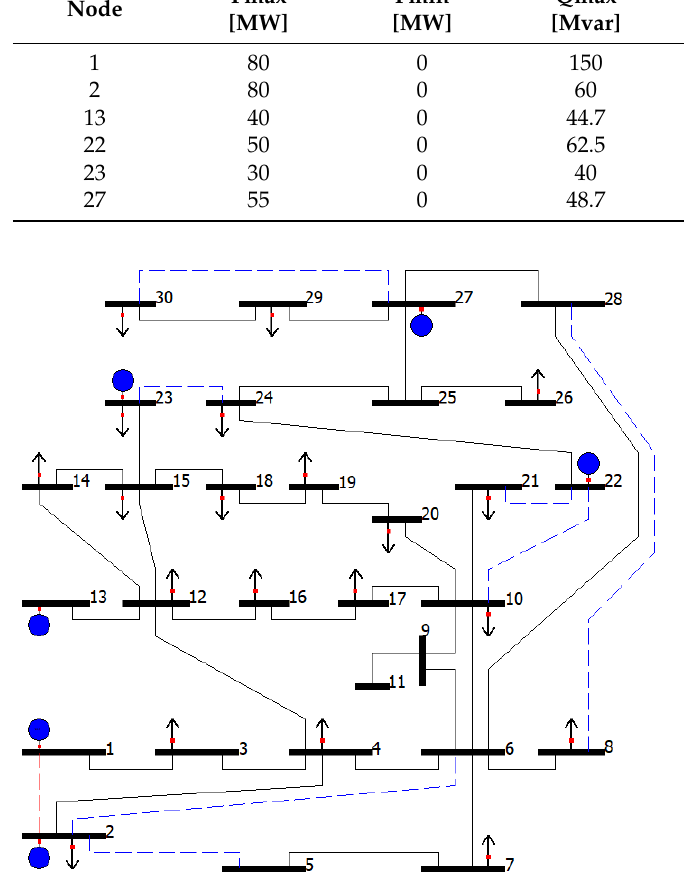
Figure 2. 30 bus bar system, contingency N − 1 and lines SW disconnected.